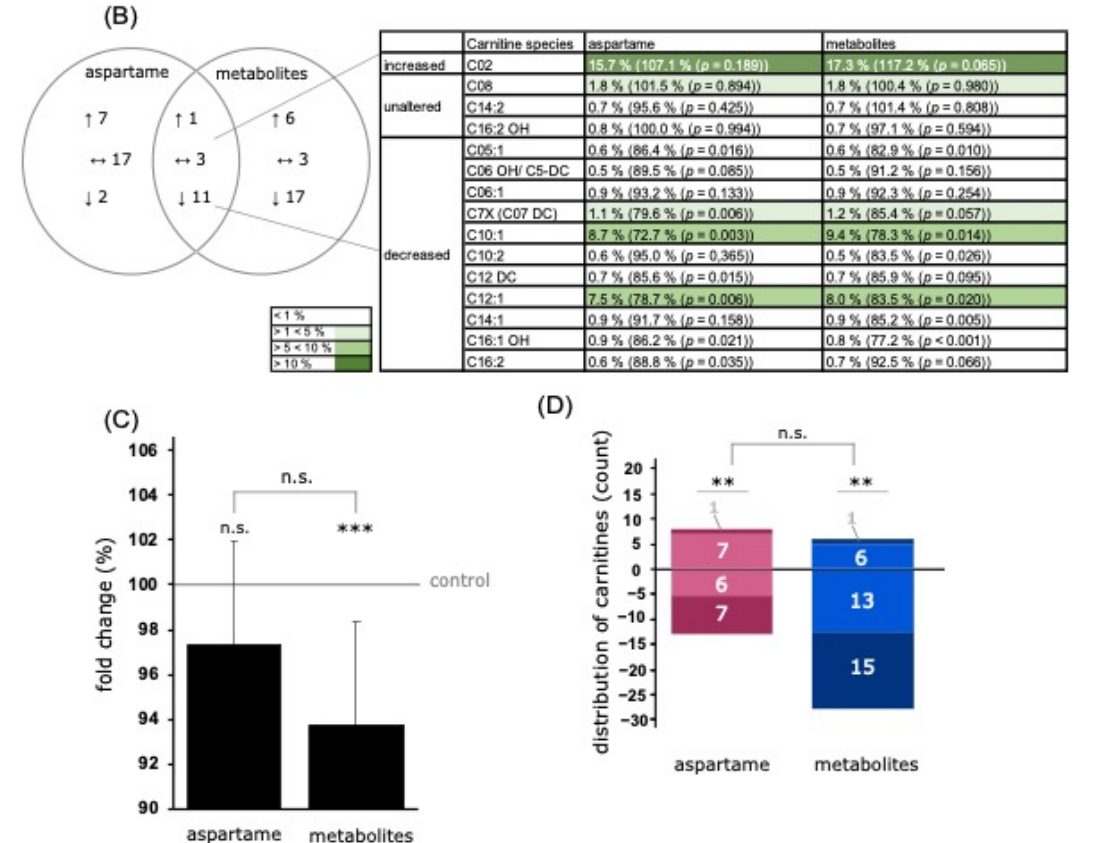
Figure 7. Effects of aspartame or aspartame metabolites on carnitine species. Neuroblastoma cells (SH-SY5Y) were treated as described before with control, aspartame, or aspartame metabolites for 48 h and analyzed using a semi-quantitative shotgun lipidomics approach. Each diagram represents the changes in the aspartame- or metabolite-treated cells in comparison to control-treated cells. ( A ) In the volcano plot, each carnitine species is graphically represented by a pink (aspartame treatment) or blue (aspartame metabolite treatment) dot which is plotted with its fold change ( x -axis) against its according p -value ( y -axis). The volcano plot is structured as the one in Figure 4. ( B ) Venn diagram of carnitine species after incubation of SH-SY5Y cells with aspartame or aspartame metabolites. Alterations of the same species are visible in the overlapping part. ( C ) The bar chart shows the relative fold change of all measured carnitine species after aspartame treatment compared to treatment with aspartame metabolites. Error bars represent the standard error of the mean (SEM), and the statistical signi fi cance was set as ** p ≤ 0.01 and *** p ≤ 0.001. ( D ) Distribution of carnitine species, classi fi ed by